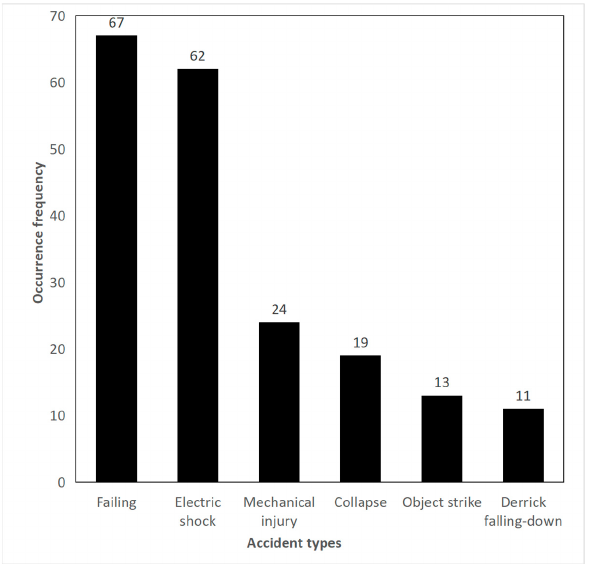
Figure 3. Statistical results of the main types of electric power personal casualty accidents (2014 to 2018).